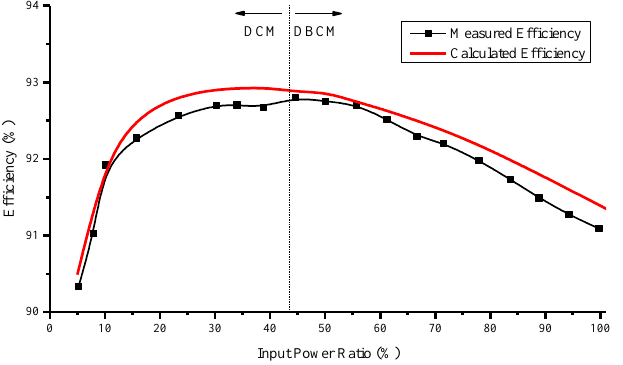
Energies 2021 , 14 , x FOR PEER REVIEW Figure 8. Calculated and measured efficiency versus power ratio for STC ( P PV,max = 180 W, V dc = 36 V).